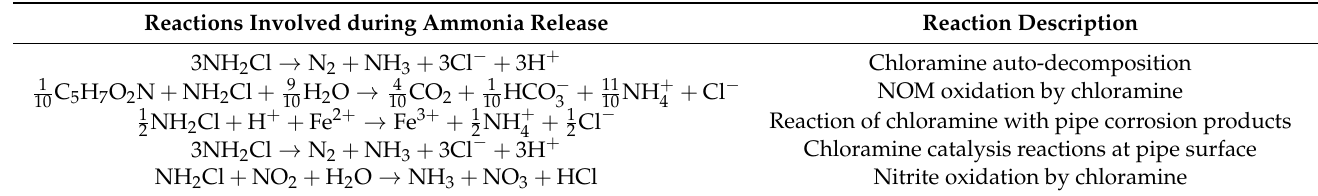
Table 1. Chemical reactions that govern the release of ammonia in the distribution system.